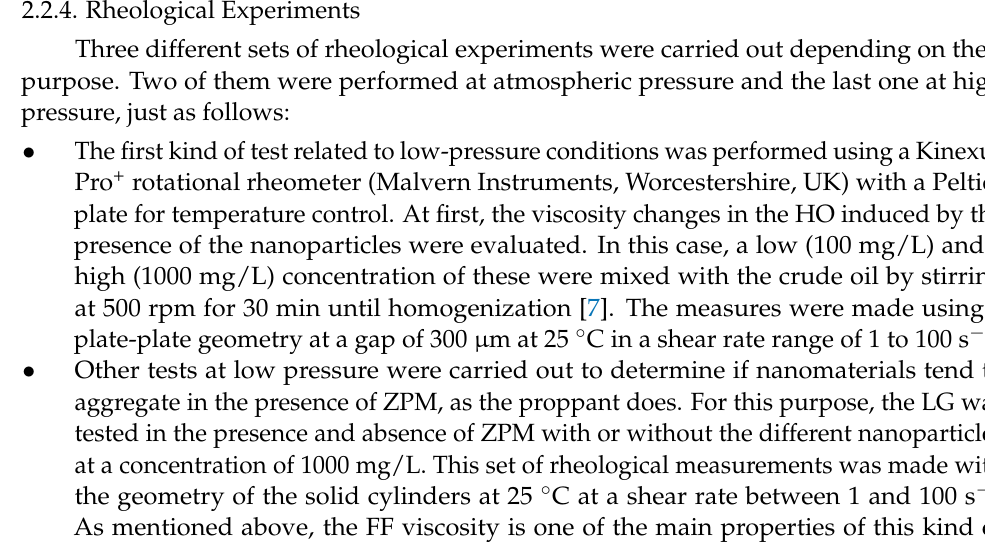
Table 2. Additives, their orders and dosages in preparing the different fracturing fluids (FF). Order Additive Dosage % v / v 1 Bactericide 0.005 2 Clay stabilizer 0.200 3 Guar gum-based polymer 0.875 4 Surfactant 0.200 5 Zeta Potential Modifier 1.500 6 pH controller 0.400 7 Delayed breaker 0.400 Peroxide breaker 0.100 Metaborate crosslinker 480